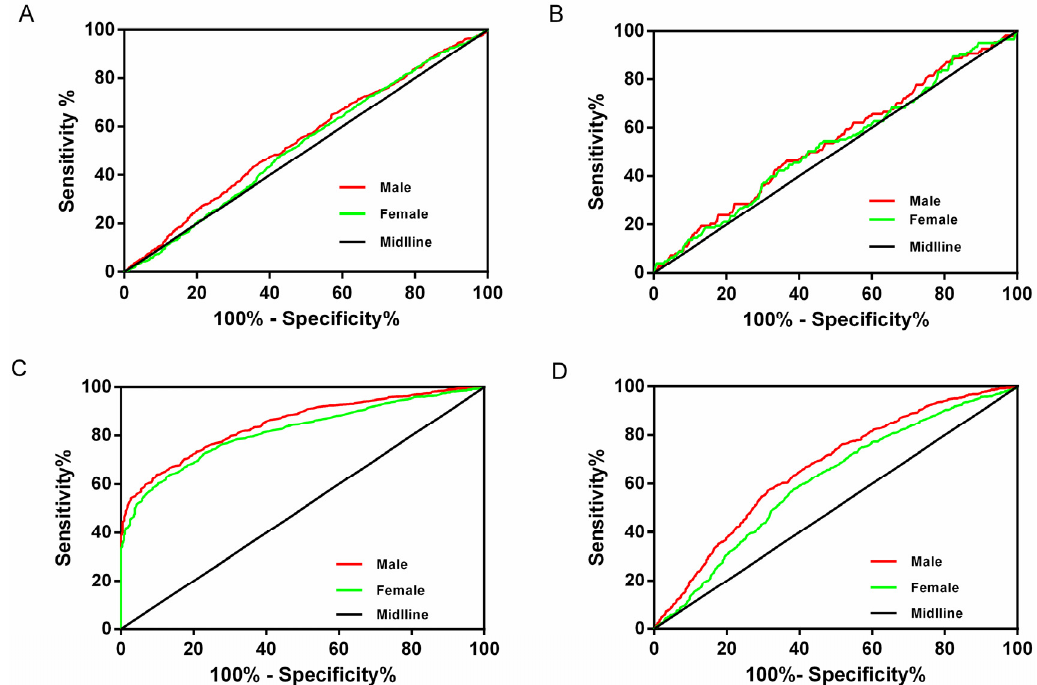
Figure 1. ROC curves to detect CVD risk factors in males and females . ( A ) ROC curves to detect hypertension in males and females; ( B ) ROC curves to detect diabetes in males and females; ( C ) ROC curves to detect dyslipidemia in males and females; ( D ) ROC curves to detect ≥ 2 of these risk factors in males and females.